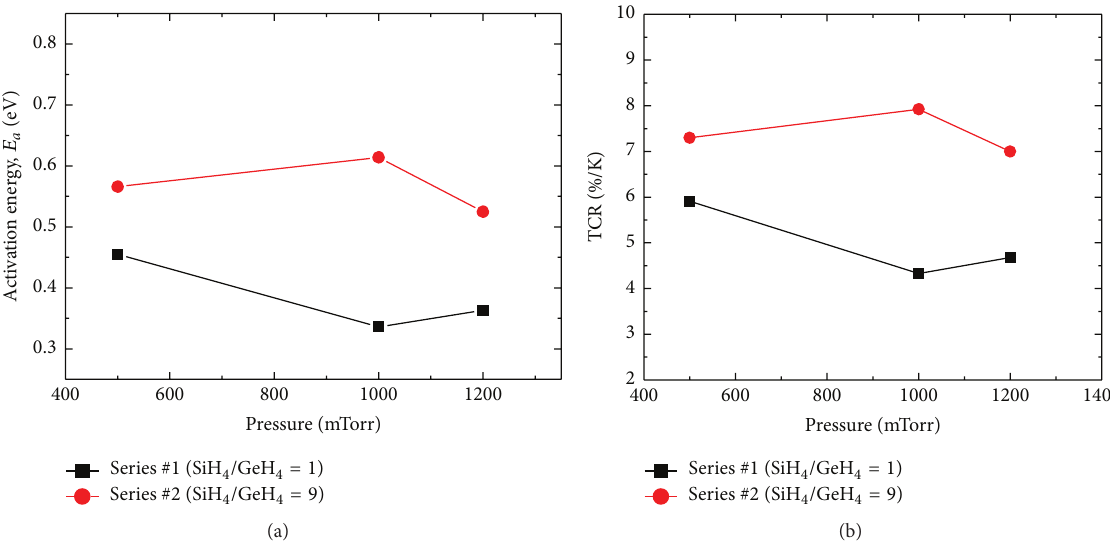
Figure 10: (a) Activation energy ( 𝐸 𝑎 ) as a function of the deposition pressure of two series of pm-Si 𝑥 Ge 𝑦 :H films. (b) TCR as a function of the deposition pressure for two series of pm-Si 𝑥 Ge 𝑦